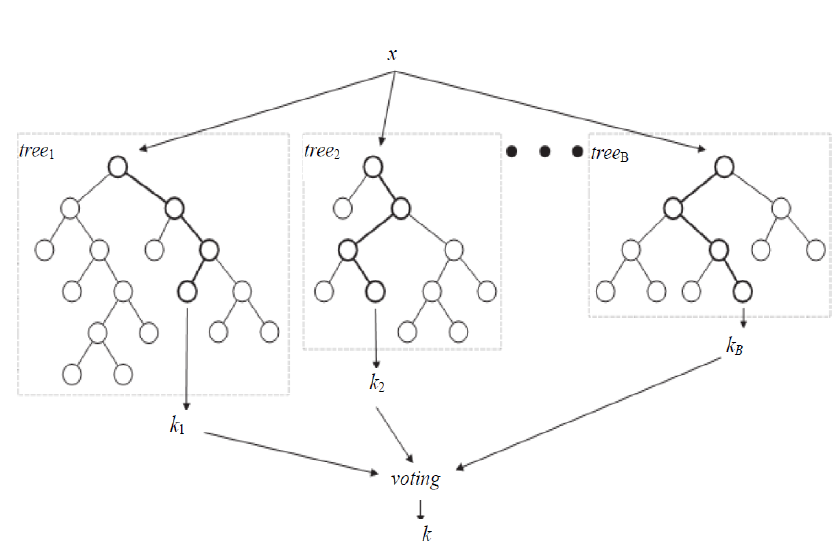
Figure 3. Structure of Random Forest